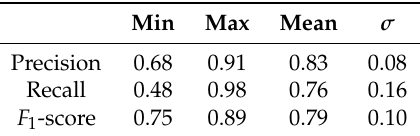
Figure 12. Detailed view of the reconstructed symptoms after growth: from seeds [ R min = 2.5, α = 0.1 ] (cid:55)−→ [ R = 1, α = 0.2] growth. Seed pixels are represented in yellow, while pixels added during the min growth phase are represented in pink. These four examples correspond to the numbered symptoms indicated in Figure 11, ( a ) Large coalesced oilspot, ( b ) crown of necrosing oilspots, ( c ) early adaxial symptoms and ( d ) early abaxial symptoms.. Table 2. Variability of the performances of symptoms reconstruction in the image database: (seeds) [ R min = 2.5, α = 0.1 ] (cid:55)−→ [ R min = 1, α = 0.2] (growth). Performances are computed for the pixel-wise